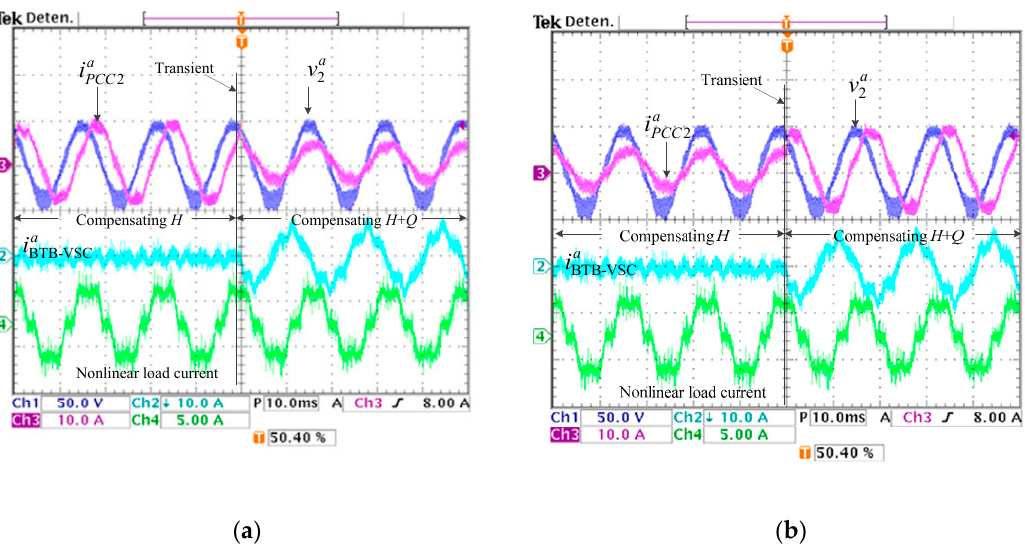
Figure 17. Test results for current harmonic and reactive power compensation: ( a ) Leading power factor and ( b ) Lagging power factor. Ch1, voltage measured at the PCC2; Ch2, current injected with the BTB-VSC; Ch3, current measured at the PCC2; Ch4, Current of the nonlinear load. Vertical sensitivities: Ch1, 50 V / div; Ch2 and Ch3, 10 A / div; Ch4, 5 A / div. Horizontal sensitivity: 10 ms /